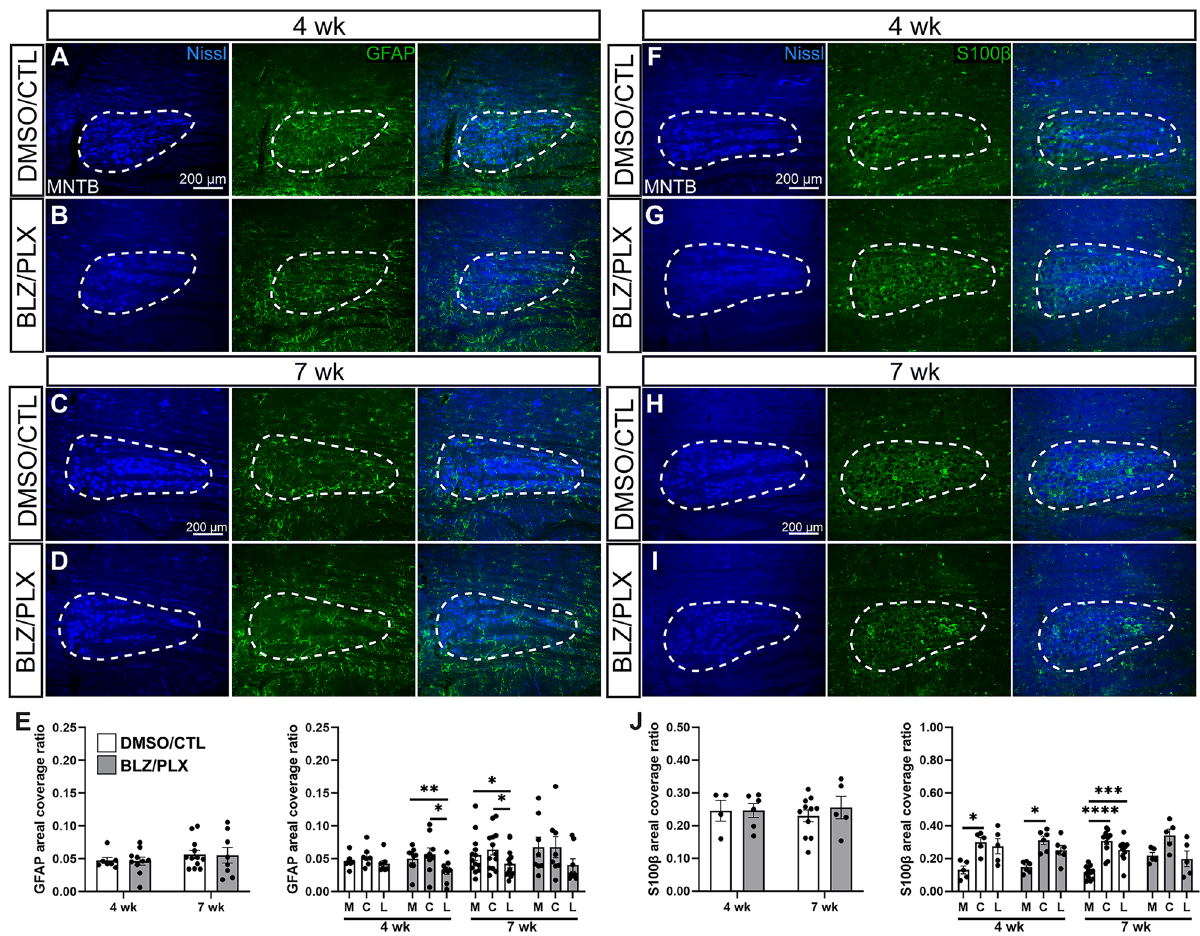
Figure 3. Effects of BLZ/PLX treatment on astrocytes are limited. ( A ) Images of Nissl (blue), GFAP (green), and an overlay in DMSO/CTL treated mice at 4 wk. White dashed lines indicate MNTB. ( B ) Nissl and GFAP immunolabeling in BLZ/PLX at 4 wk. ( C ) Nissl and GFAP immunolabeling in 7 wk controls. ( D ) Nissl and GFAP expression in 7 wk BLZ/PLX mice. ( E ) Comparison of overall GFAP areal coverage ratio and medial, central and lateral GFAP coveragein the MNTB of 4 and 7 wk mice. Overall treatment effects were not detected. BLZ/PLX mice at 4 wk showed less GFAP coverage in lateral and central MNTB, compared to the medial region, while DMSO/CTL mice did not show region specificity. At 7 wk, DMSO/CTL mice had lower GFAP expression levels in lateral compared to medial and central regions. BLZ/PLX did not show a regional difference at 7 wk. ( F ) Images of Nissl (blue), S100β (green) immunolabeling with an overlay in DMSO/CTL treated mice at 4 wk. ( G ) Nissl and S100β staining in BLZ/PLX mice at 4 wk. ( H ) Nissl and S100β immunolabeling in 7 wk DMSO/CTL mice. I) Nissl and S100β immunolabeled sections from BLZ/PLX mice at 7 wk. ( J ) Comparison of overall and regional S100β areal coverage ratio in the MNTB of 4 and 7 wk mice. Treatment effects were not detected. Both DMSO/CTL and BLZ/PLX treated mice at 4 wk showed higher S100β levels in central MNTB compared to the medial region. At 7 wk, regional differences in the DMSO/CTL group were evident, while the BLZ/PLX group did not show any differences. * p < 0.05. Scalebars = 200 µm, apply to panels ( A ) – ( D ) and ( G ) – ( J